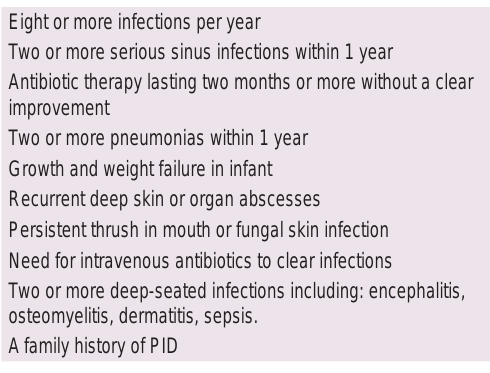
TABLE 1. Problems suggesting immune defi ciency